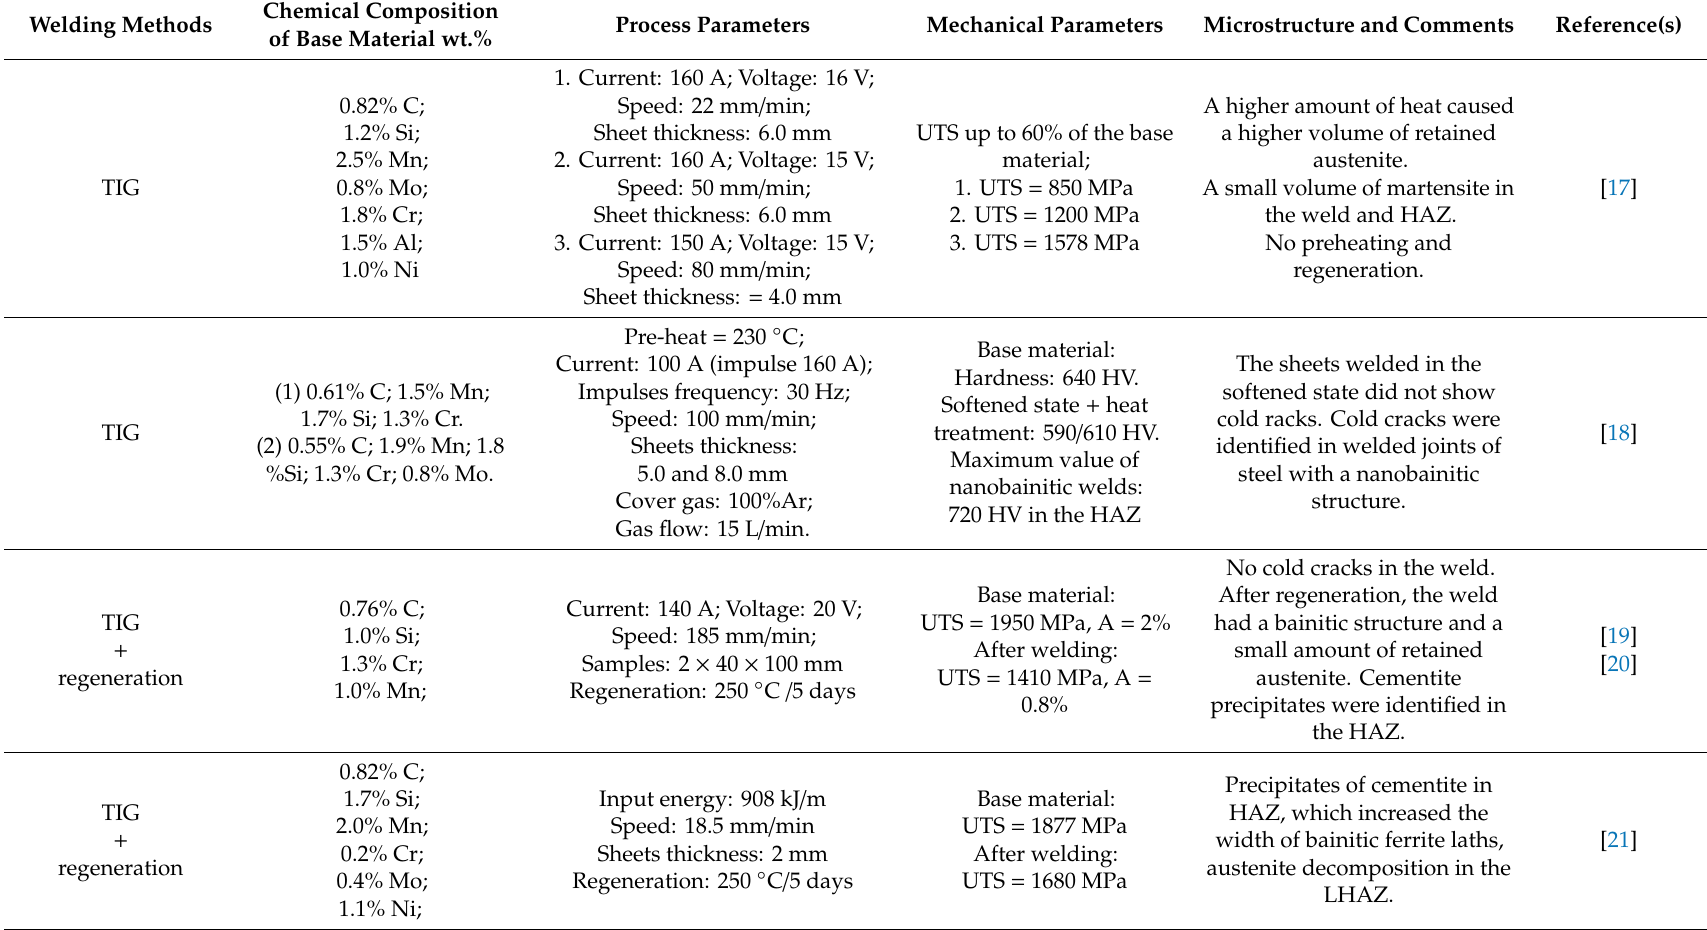
Table 2. Review of welding methods for nanostructured carbide-free bainite and for selected steels after quenching and partitioning(Q&P) heat treatment. Welding